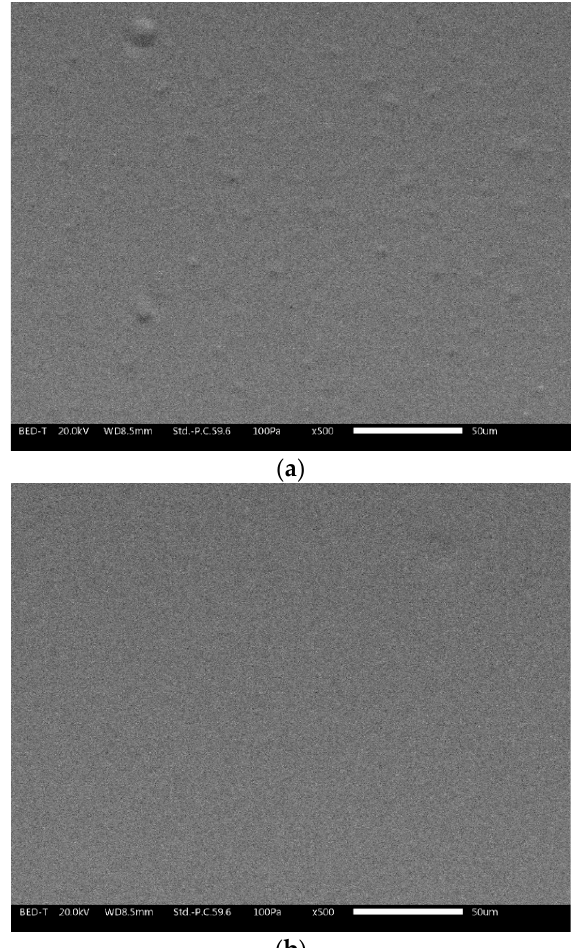
Figure 9. SEM (BED-topographic) pictures of the sample 3 wt.% at time 0 ( a ) and after 96 h of exposure ( b